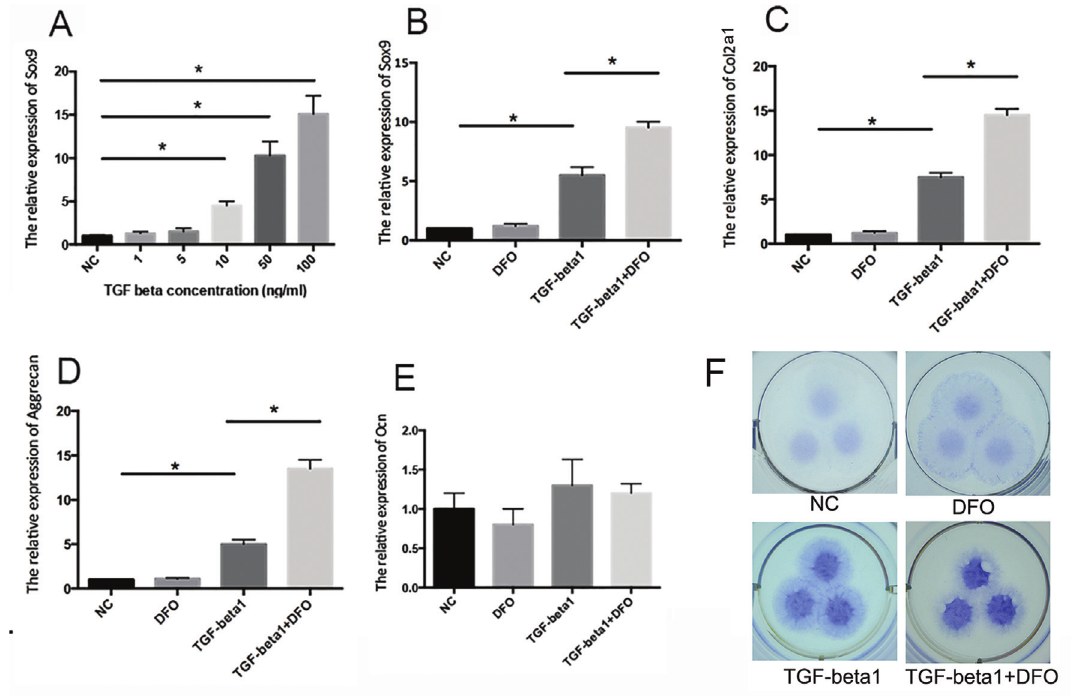
Figure 1 - DFO synergizes with TGF- (cid:15) 1 in chondrogenesis in ATDC5 cells. (A) Sox9 gene expression in ATDC5 cells treated with different concentra- tions of TGF- (cid:15) 1. NC – non-treated control cells. *p < 0.05 compared to NC cells. (B-E) ATDC5 cells were treated with DFO, TGF- (cid:15) 1 or both for three days,afterwhichSox9(B),Col2a1(C),aggrecan(D)andOcn(E)geneexpressionwasassessed.InpanelsA-E,thecolumnsrepresentthemean+1SD(n = 3 each). *p < 0.05 for cells treated with TGF- (cid:15) 1 vs. NC cells and for cells treated with TGF- (cid:15) 1 vs. cells treated with TGF- (cid:15) 1 + DFO. (F) ATDC5 cells were treated with DFO, TGF- (cid:15) 1 or both for seven days in micromass culture. The cells were then fixed and stained with Alcian blue. This assay was done in